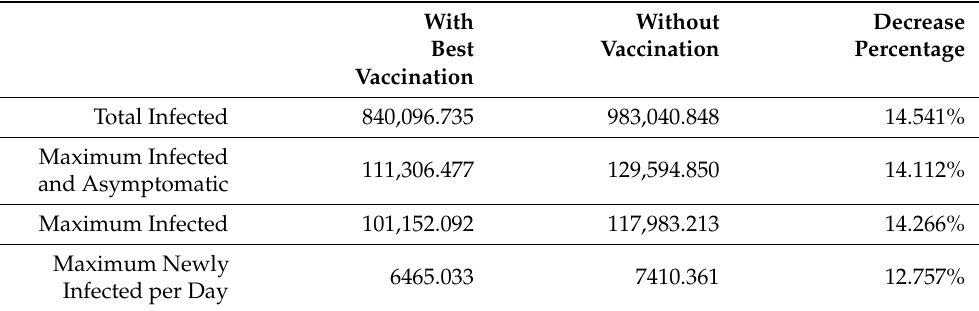
Table 14. Comparison table of infections with and without vaccination.